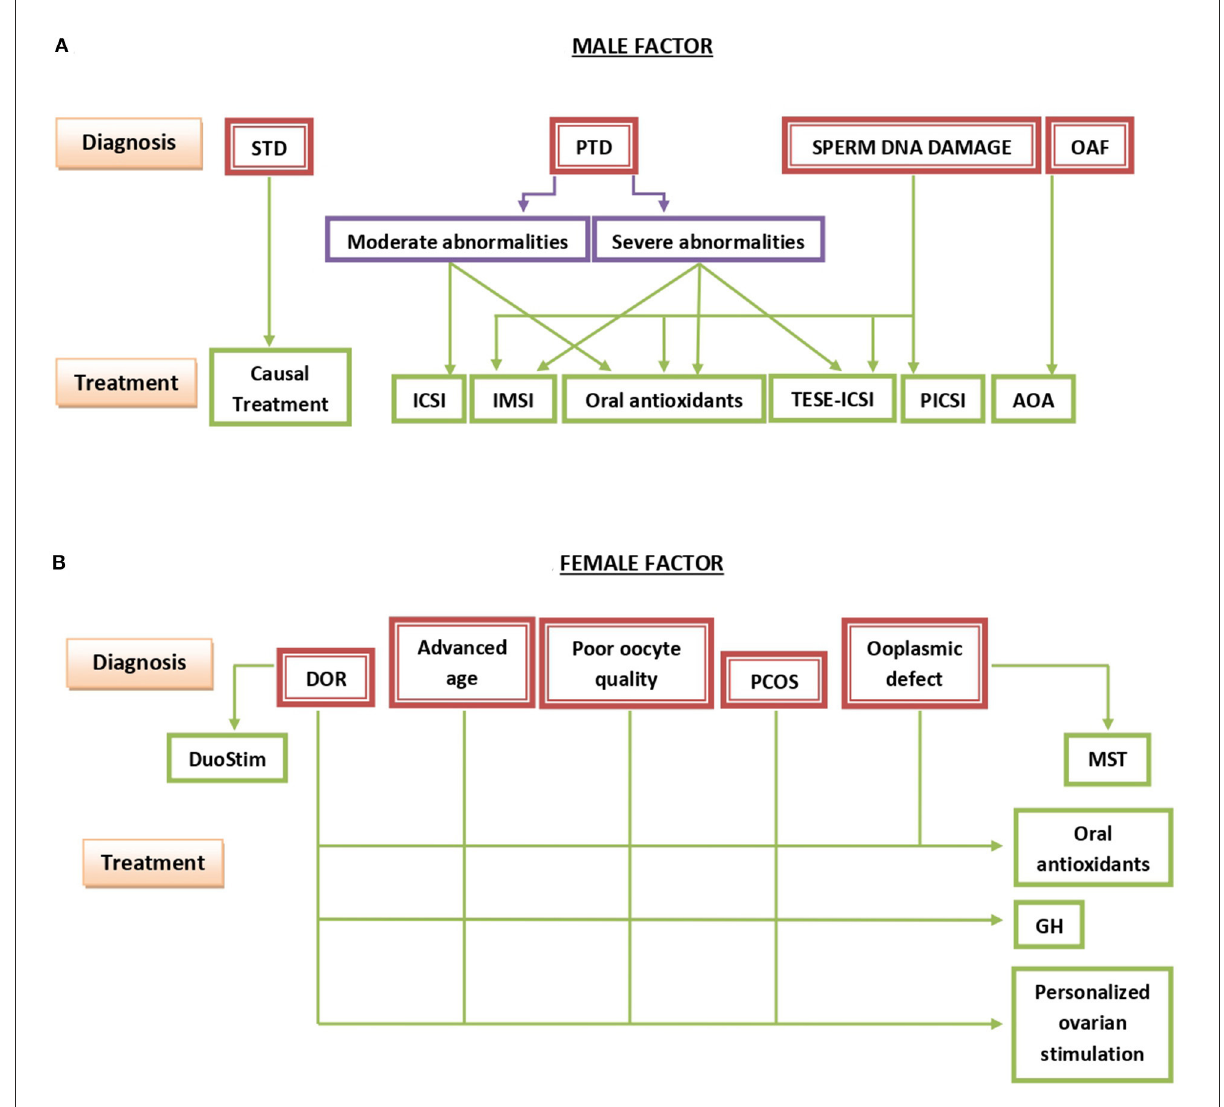
FIGURE2 Summary of the basic points outlining the management of infertility due to the male (A) or the female (B) factor. STD, secondary testicular disease; PTD, primary testicular disease; OAF, oocyte activation failure; ICSI, intracytoplasmic sperm injection; IMSI, intracytoplasmic morphologically-selected sperm injection; TESE-ICSI, ICSI with spermatozoa recovered by testicular sperm extraction; PICSI, physiologic ICSI; AOA, assisted oocyte activation; DOR, diminished ovarian reserve; PCOS, polycystic ovary syndrome; DuoStim, double ovarian stimulation; MST, meiotic spindle transfer; GH, growth